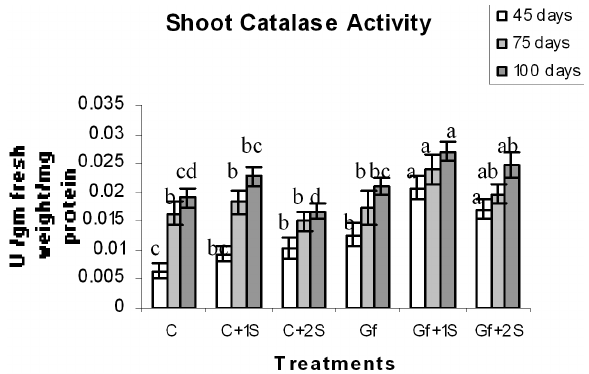
Fig. 7. Root peroxidase activity in Gmelina arborea Roxb inocu- lated with Glomus fasciculatum after 45, 75 and 100 days after AM inoculation